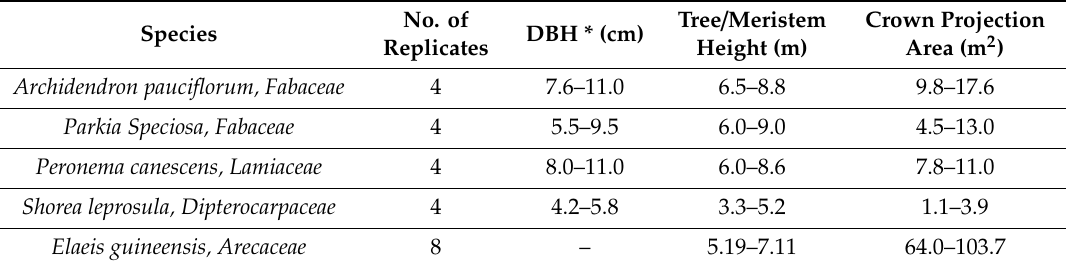
Table 1. Tree and palm